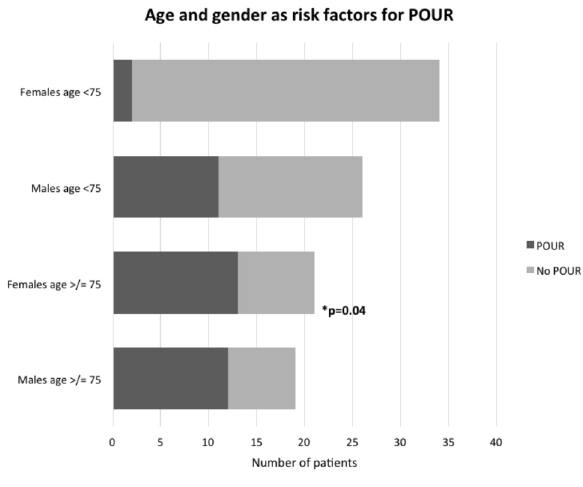
POUR following lower limb arthroplasty is significantly Fig. 3: associated with increasing age, irrespective of